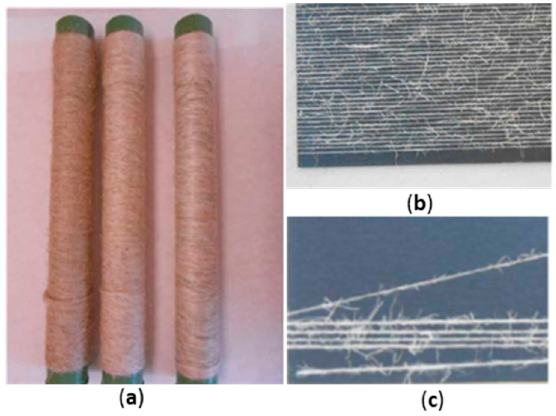
Figure 9. Pictures showing: ( a ) rovings obtained with the three blends; ( b ) banana/wool yarn; ( c ) 2 ply banana/wool yarn.